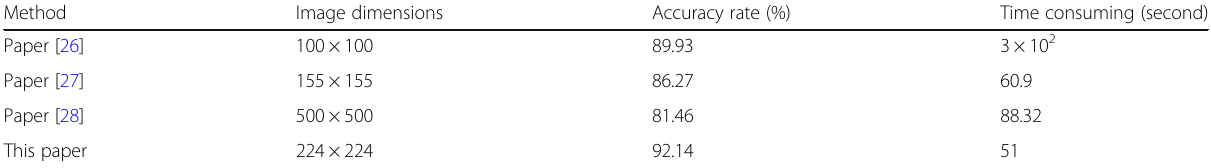
Table 1 Comparison of image processing results with different methods Method Image